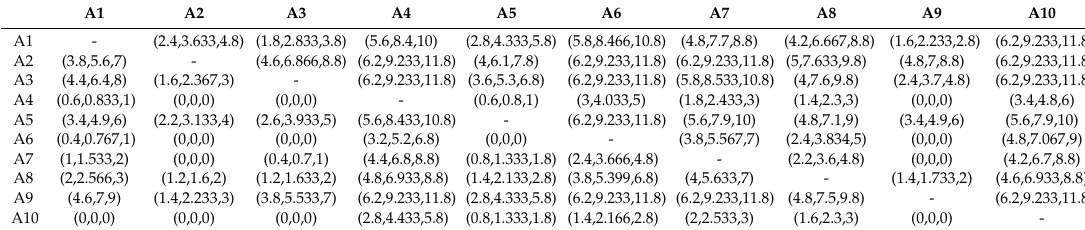
Table 22. The concordance matrix.